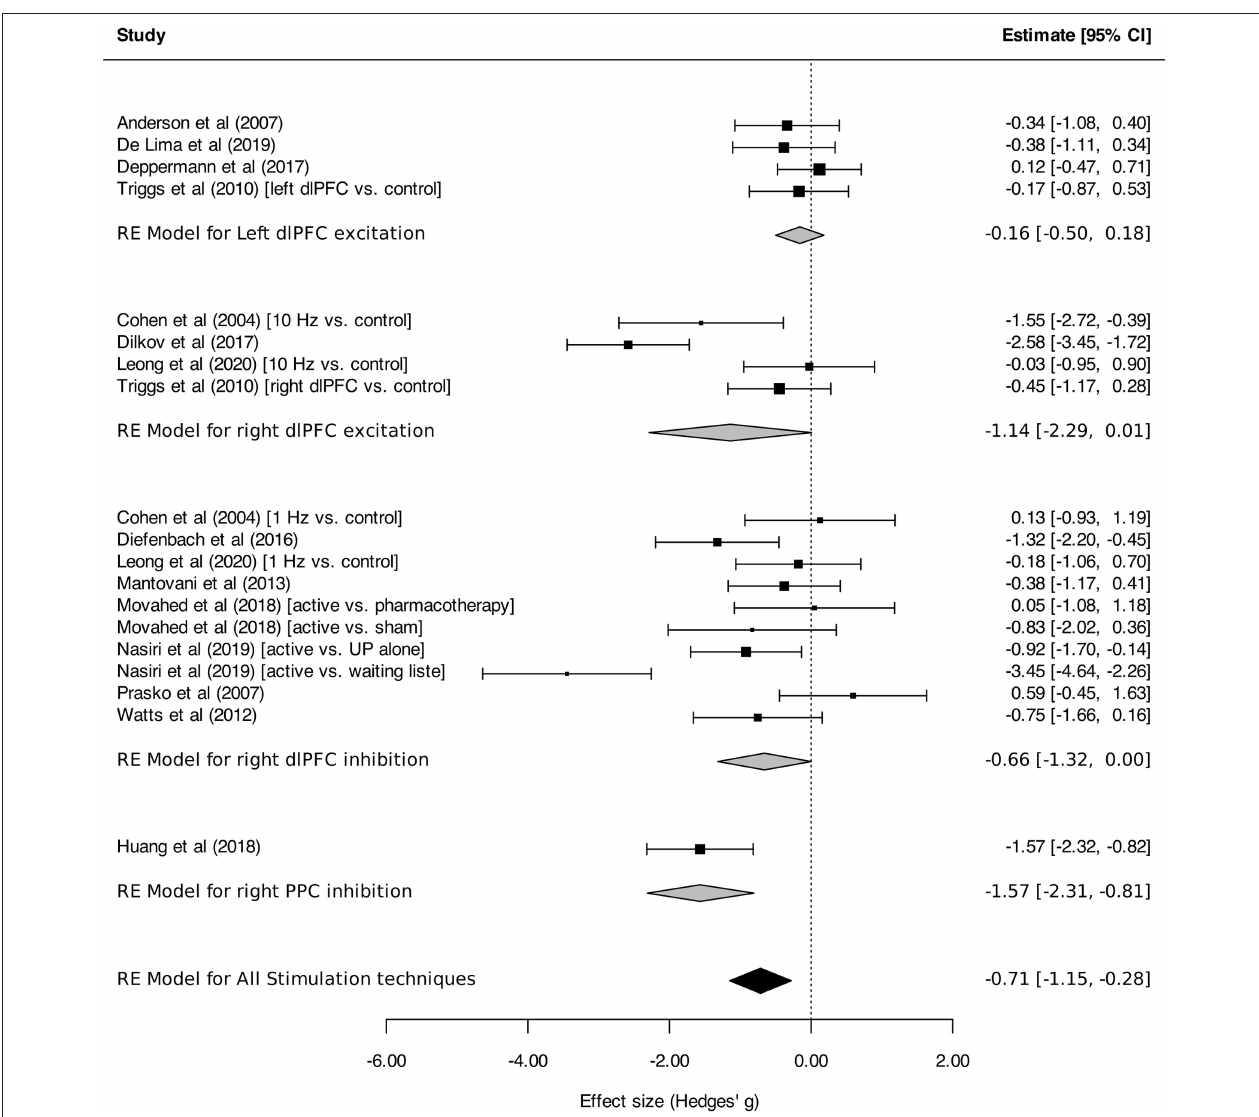
FIGURE 4 | Change in the anxiety symptoms intensity in anxiety, stressor-related disorders and MDD, subgroups by target brain region. Statistics: left dlPFC excitation: heterogeneity Sigma1 2 = 0.00, Sigma2 2 = 0.00; Q(df = 3) = 1.44, p = 0.70; I 2 = 00%; test for overall effect: Z = − 0.91 ( p = 0.36); right dlPFC excitation: heterogeneity Sigma1 2 = 0.57, Sigma2 2 = 0.57; Q(df = 3) = 20.21, p = 0.0002; test for overall effect: Z = − 1.95 ( p = 0.0002; I 2 = 85%); right dlPFC inhibition: heterogeneity Sigma1 2 = 0.15, Sigma2 2 = 0.68; Q(df = 9) = 34.66, p < 0.0001; I 2 = 78%; test for overall effect: Z = − 1.95 ( p = 0.05); right PPC (posterior parietal cortex) inhibition: heterogeneity : not applicable; test for overall effect: Z = − 4.09 ( p <